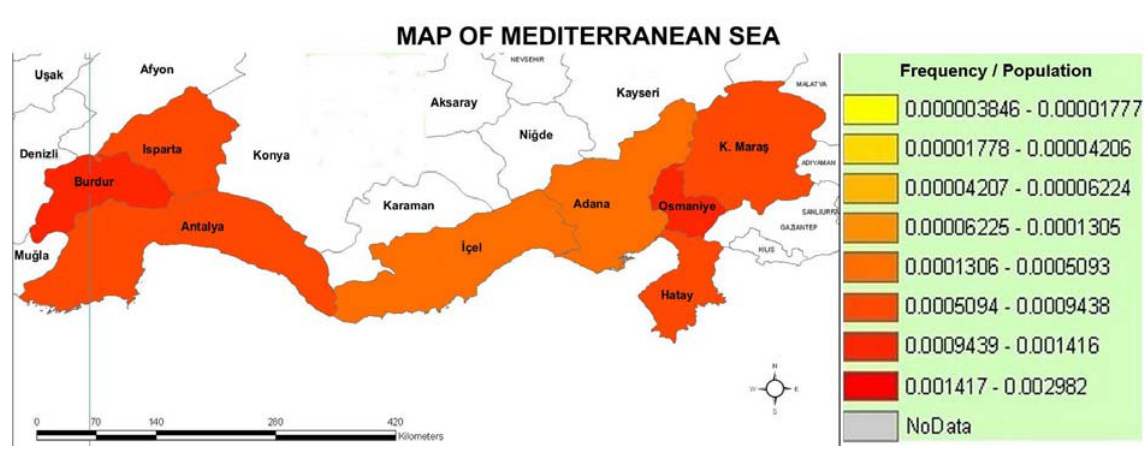
Figure 3. The majority of scorpion stings were seen in Antalya, Kahramanmaras, Icel, and Hatay Provinces of the Mediterranean Sea region.